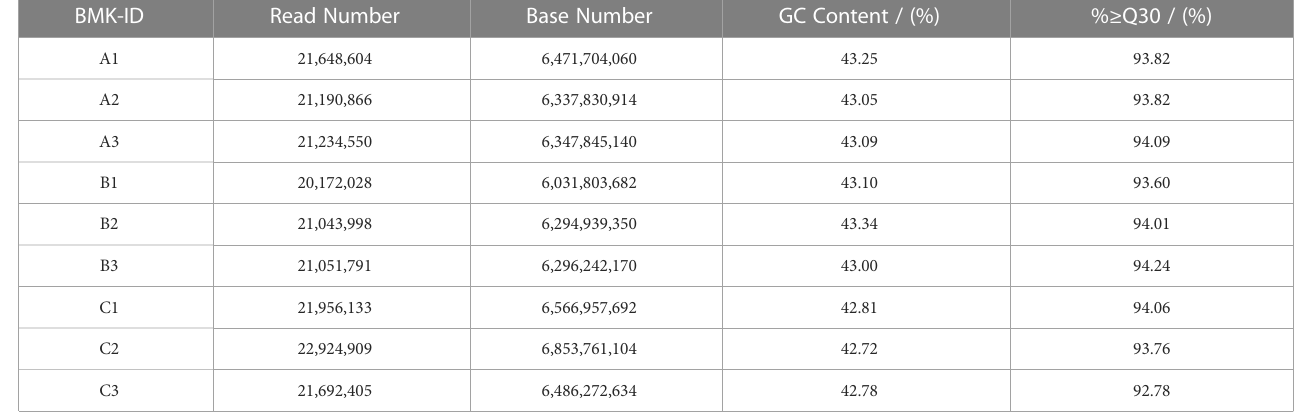
TABLE 4 Sequencing data of